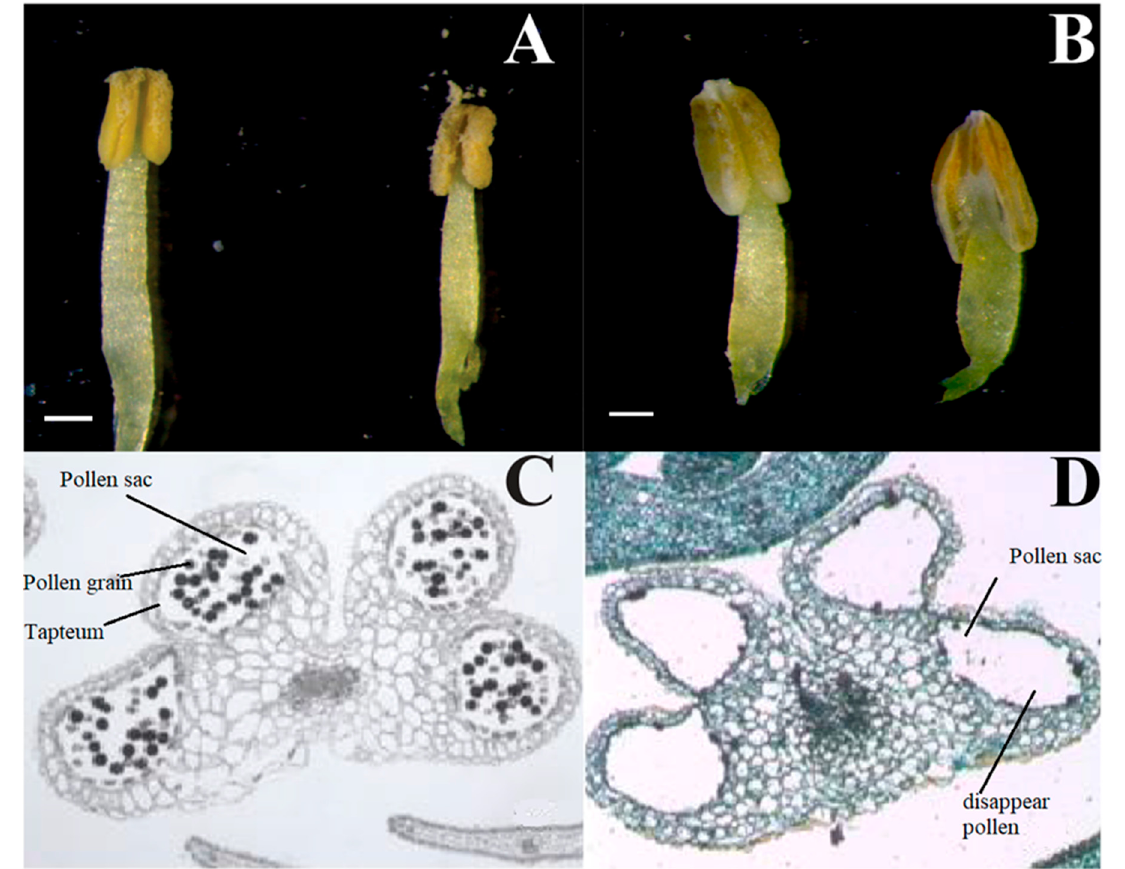
Figure 1. Phenotypic characterization of fl oral organs and cytological characterization of the anther. Fertile fl ower of restorer line MF ( A ). Sterile anther of CMS line ( B ). Bars = 0.5 cm. Fertile anther of restorer line MF ( C ). Sterile anther of CMS line ( D ). Table 1. Distribution of small RNAs in cabbage flower buds from MF and CMS